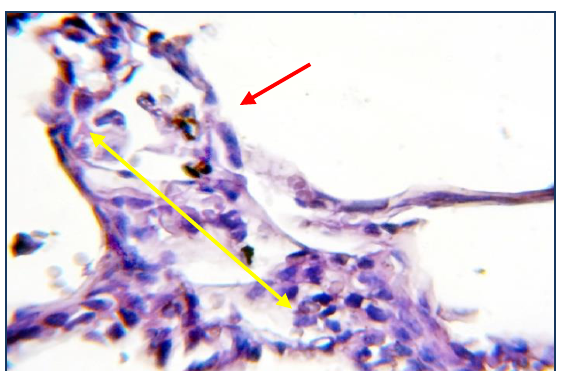
Fig, 2: Histopathological section in the lung of cat showing proliferation of pneumocytes type II with macrophages engulf tachyzoites in the alveolar lumina (H&Estain 40X).